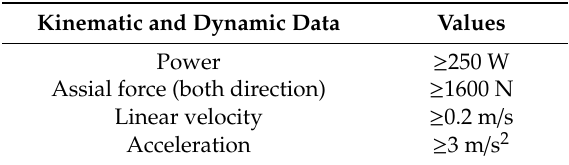
Table 4. Data for selecting the electrical motor and the